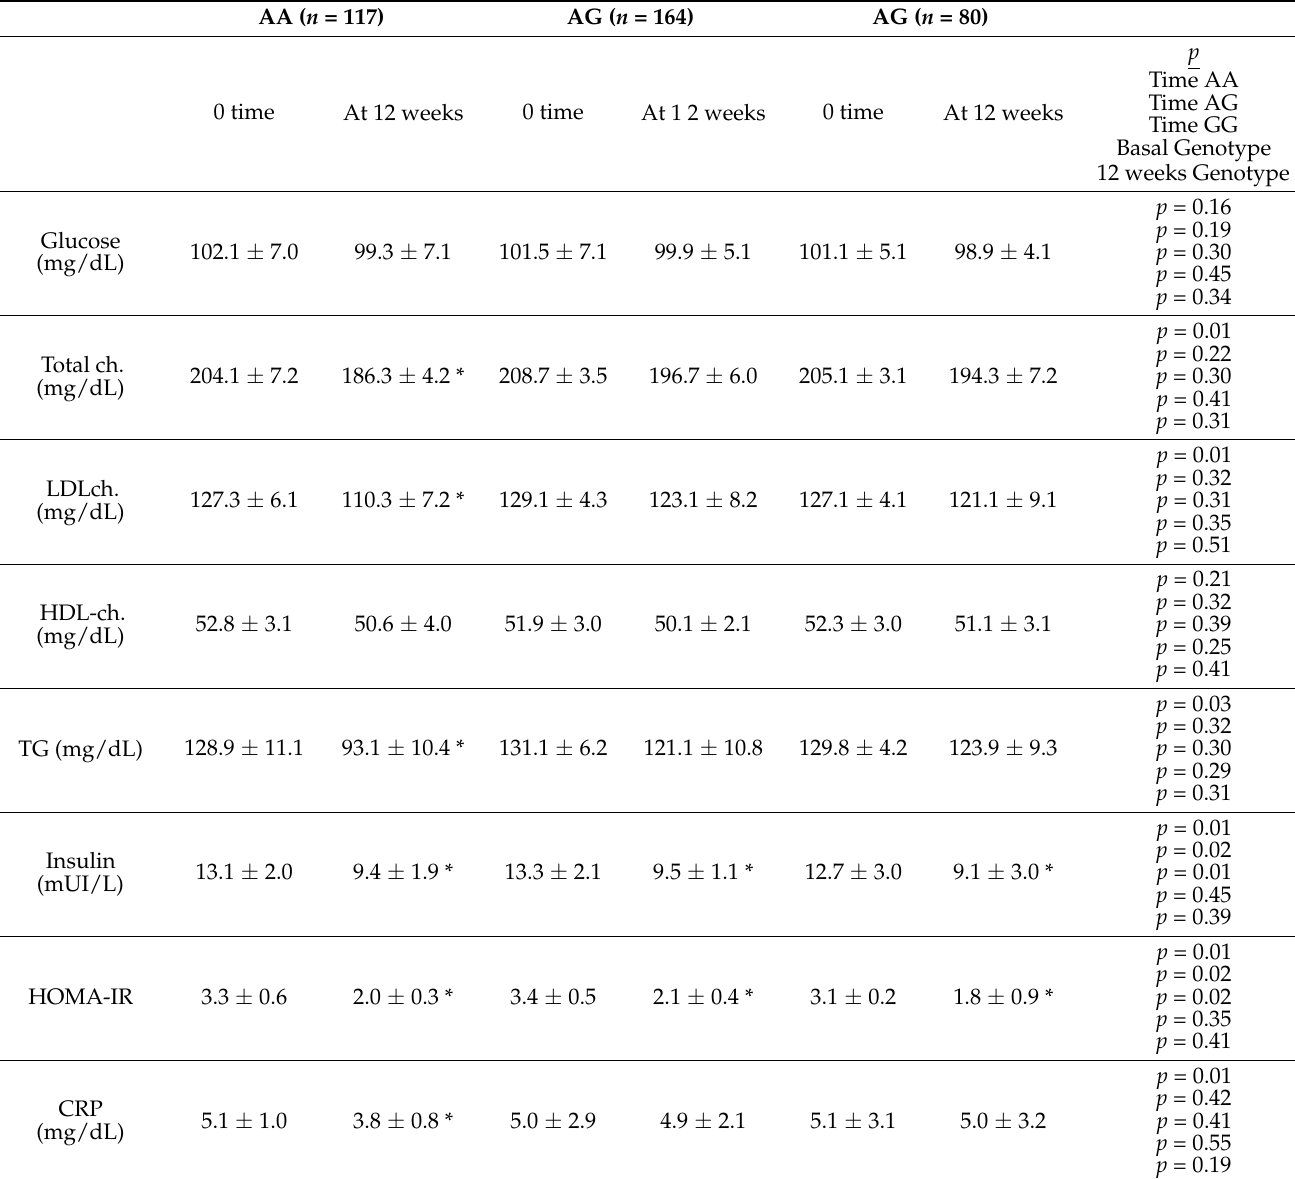
Table 2. Biochemical parameters rs3774261 (mean ±